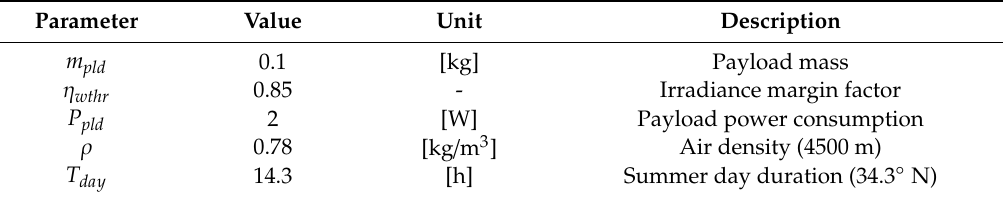
Table 2. Mission parameters for Mini-Phantom